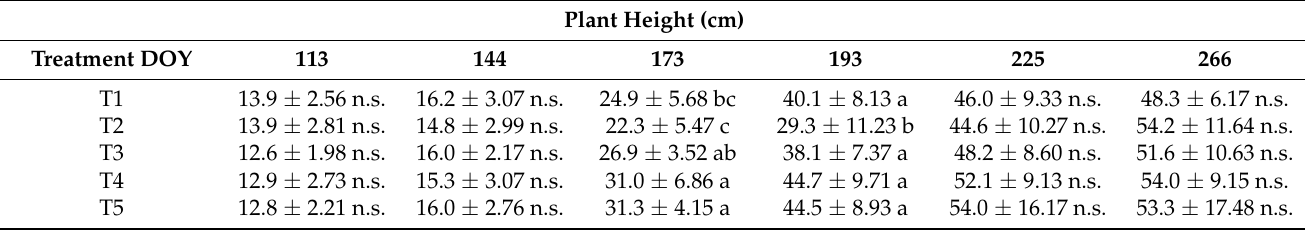
Table 3. Effects of substrates with different compost ratio (0–10–20–40%) on plant height during the growth season. Means followed by the same letter do not significantly differ at p < 0.05. DOY = day of year. Data are reported as mean values ( n = 12) ± SD, n.s. = not significant. Plant Height (cm)